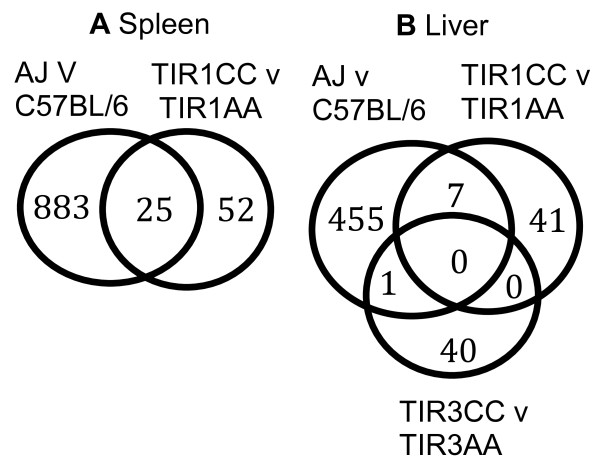
Venn diagrams, showing the numbers of genes differentially expressed in each condition. A spleen, B liver. Only 3 of the 25 genes differentially expressed in both parental and congenic spleen were outside the congenic interval and none of the 7 genes that were differentially expressed in the liver in both parental and Tir1 congenic mice were outside the congenic interval. Differential expression was defined as absolute log2 fold change > 0.5 and pplr < 0.005.